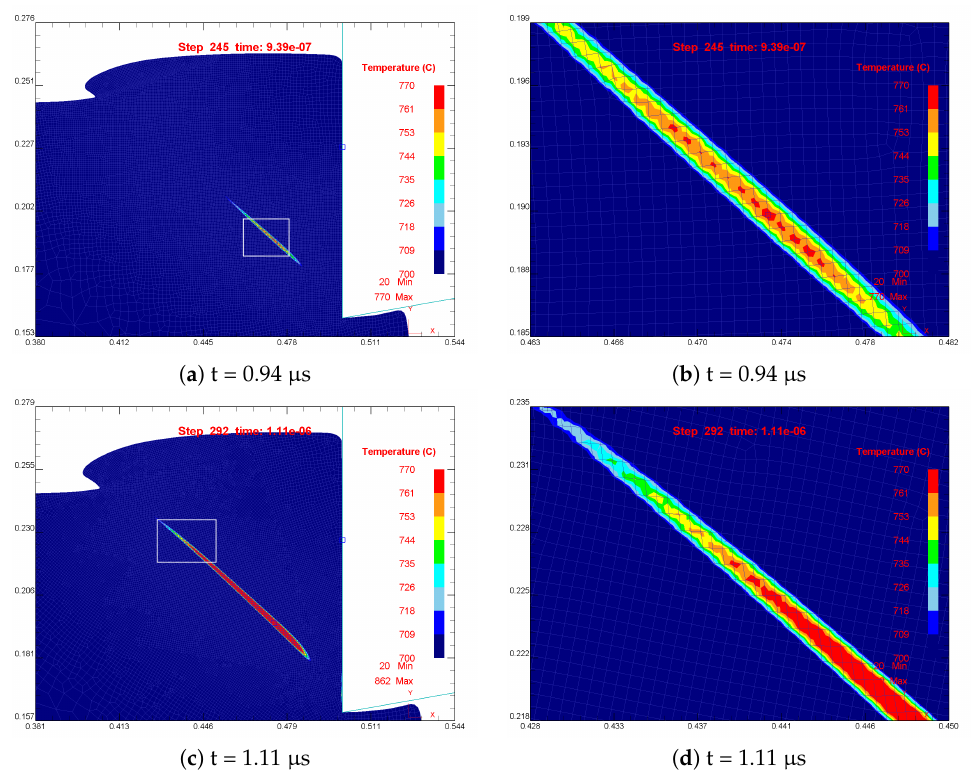
Figure 13. The micro-structure spatial temperature profile of adiabatic shear band: ( a ) Level one (1); ( b ) level two (1); ( c ) level one (2); ( d ) level two